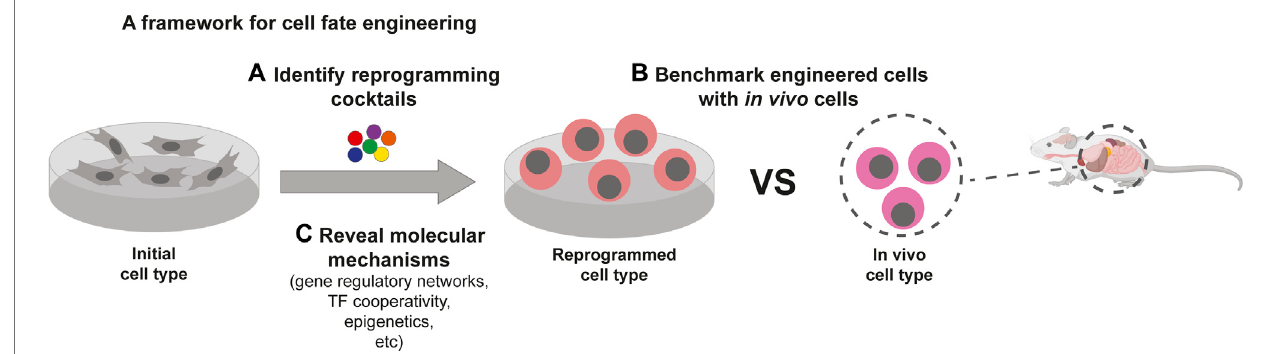
FIGURE 1 | Three key pillars of cell fate engineering. A generalizable framework for cell fate engineering will require: (A) the ability to discover new reprogramming cocktails at scale, (B) reliable ways to benchmark engineered cells with their endogenous counterparts, and (C) a deeper understanding of the underlying molecular mechanisms of cell fate conversion. Part of this fi gure was created with